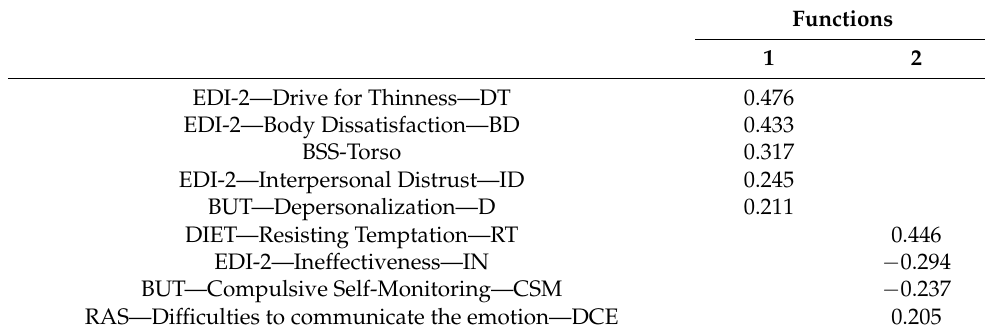
Table 2. Correlations between the discriminating variables and the canonical functions.